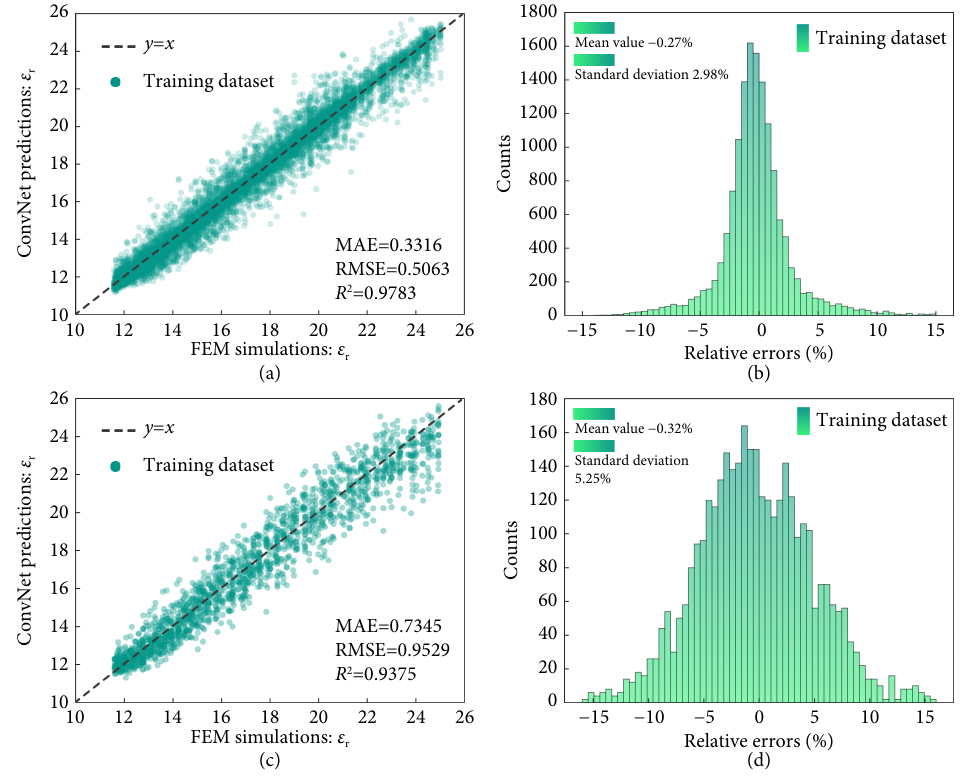
Fig. 7 The performance of Resnet-50 model for prediction of the relative permittivity of BT/PVDF nanocomposites on the (a) training data and (c) testing data and the corresponding relative errors distribution on the (b) training data and (d) testing